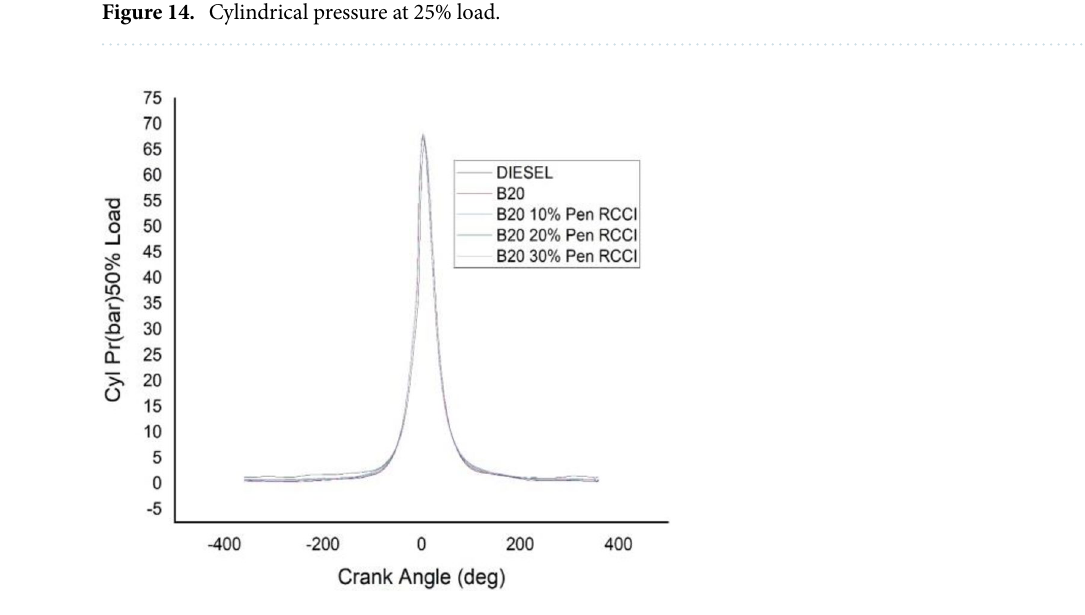
Figure 15. Cylindrical pressure at 50%